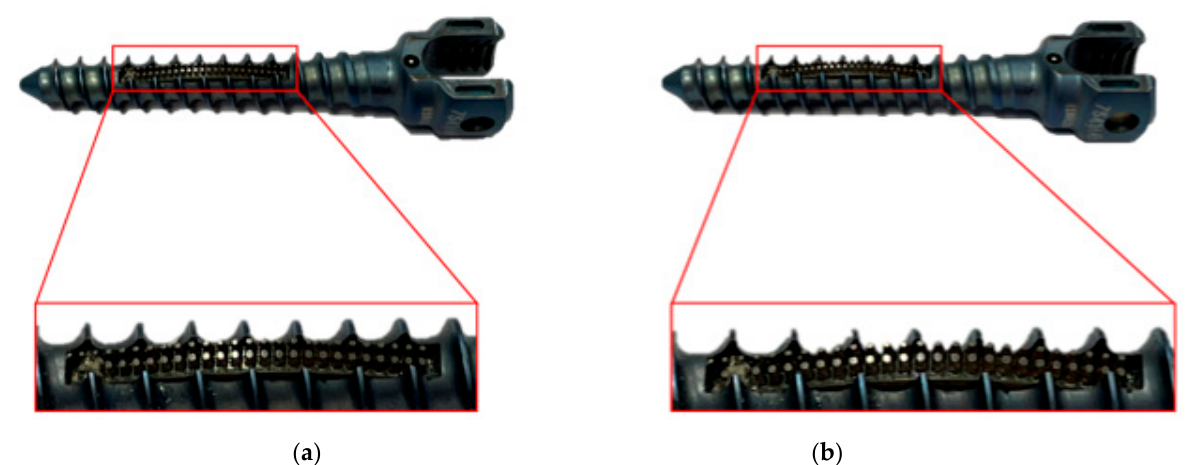
Figure 12. Detailed images of the functionalized pedicle screw with integrated hybridized NiTi SMA sheets: ( a) Before and ( b ) after three pullout tests.